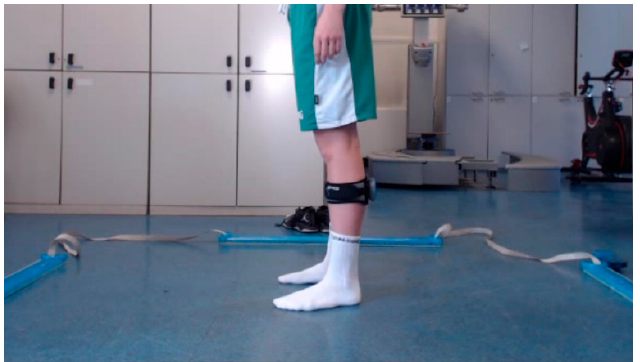
Figure 1. Subject equipped with the inertial sensor on the black stripe and placed within the area defined by the optoelectronic bars.